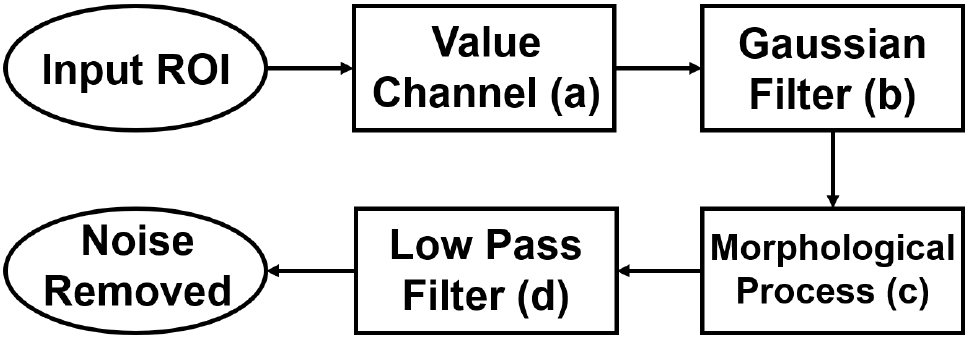
Figure 12. Flowchart of blood-vessel and noise removal (( a – d ) correspond to Figure 13).